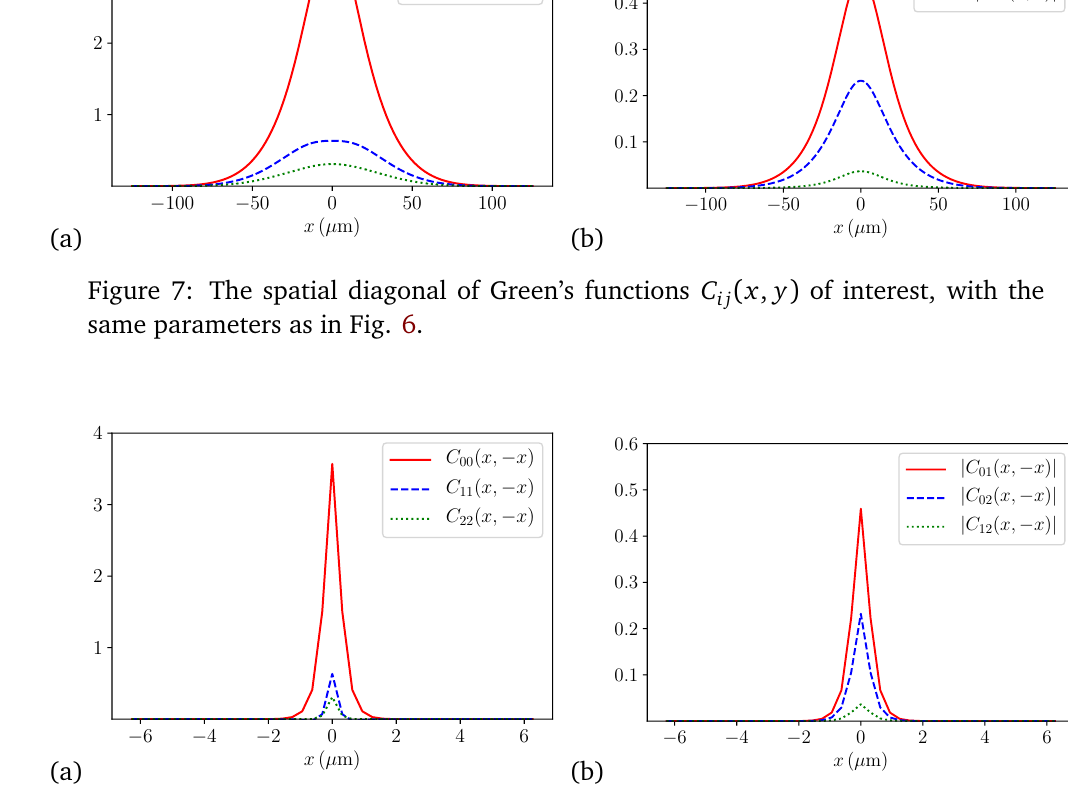
Figure 8: The spatial anti-diagonal of Green’s functions C same parameters as in Fig.